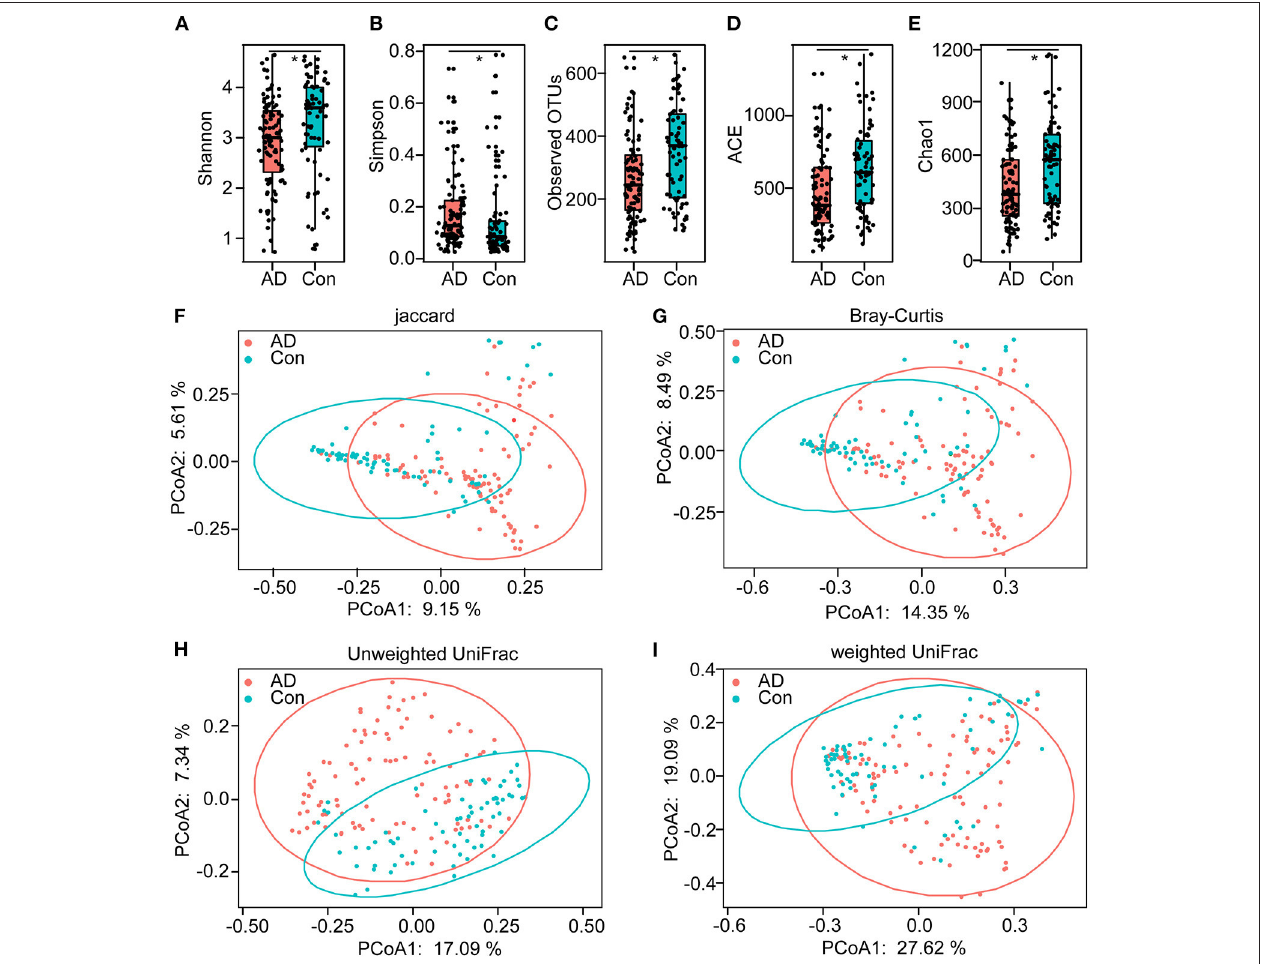
FIGURE 1 | The altered bacterial diversity and richness of the fecal microbiota in Chinese AD patients. The diversity indices of Shannon (A) and Simpson (B) , and the richness indices of the observed OTUs (C) , ACE (D) , and Chao1 (E) were used to evaluate the overall structure of the fecal microbiota in the AD patients and the healthy controls. The data are presented as mean ± standard deviation. Unpaired t -tests (two tailed) were used to analyze the variation between the groups. Principal coordinate analysis (PCoA) plots of individual fecal microbiota based on Jaccard (F) , Bray–Curtis (G) , and unweighted (H) and weighted (I) UniFrac distances in the Chinese AD patients and the healthy controls. Each symbol represents a sample. * p <